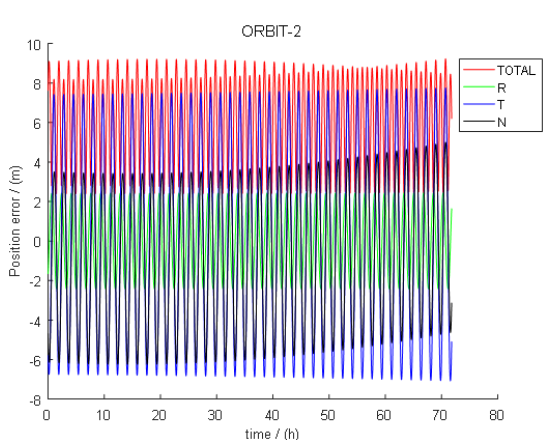
Figure 6. Comparison of overlapping arcs of three types of orbits based on orbit determination strategy